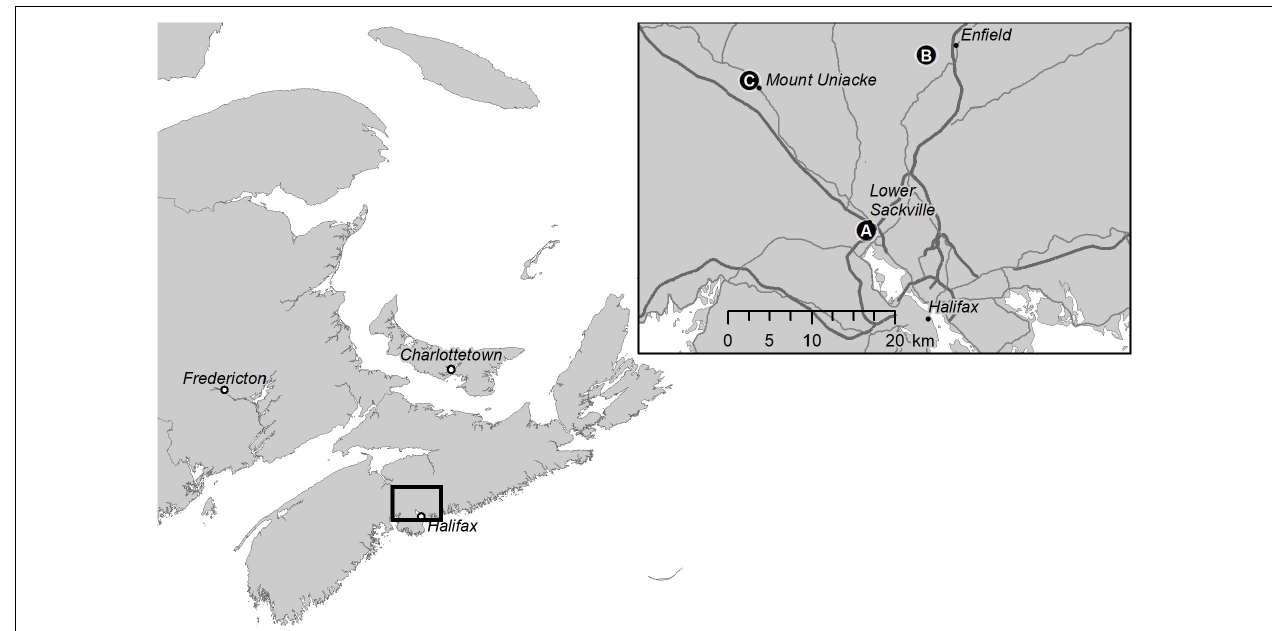
FIGURE 2 | Map showing the location of beech weevil impact plots in Nova Scotia, Canada: (A) Sandy Lake; (B) Oakfield Provincial Park; and (C) Mount Uniacke. TABLE 1 | Mean ( ± SE) numbers of stems per plot of American beech and other tree species at three forested sites in Nova Scotia, Canada, in 2014. Species Mount Uniacke Oakfield Sandy Lake Overall mean SE mean